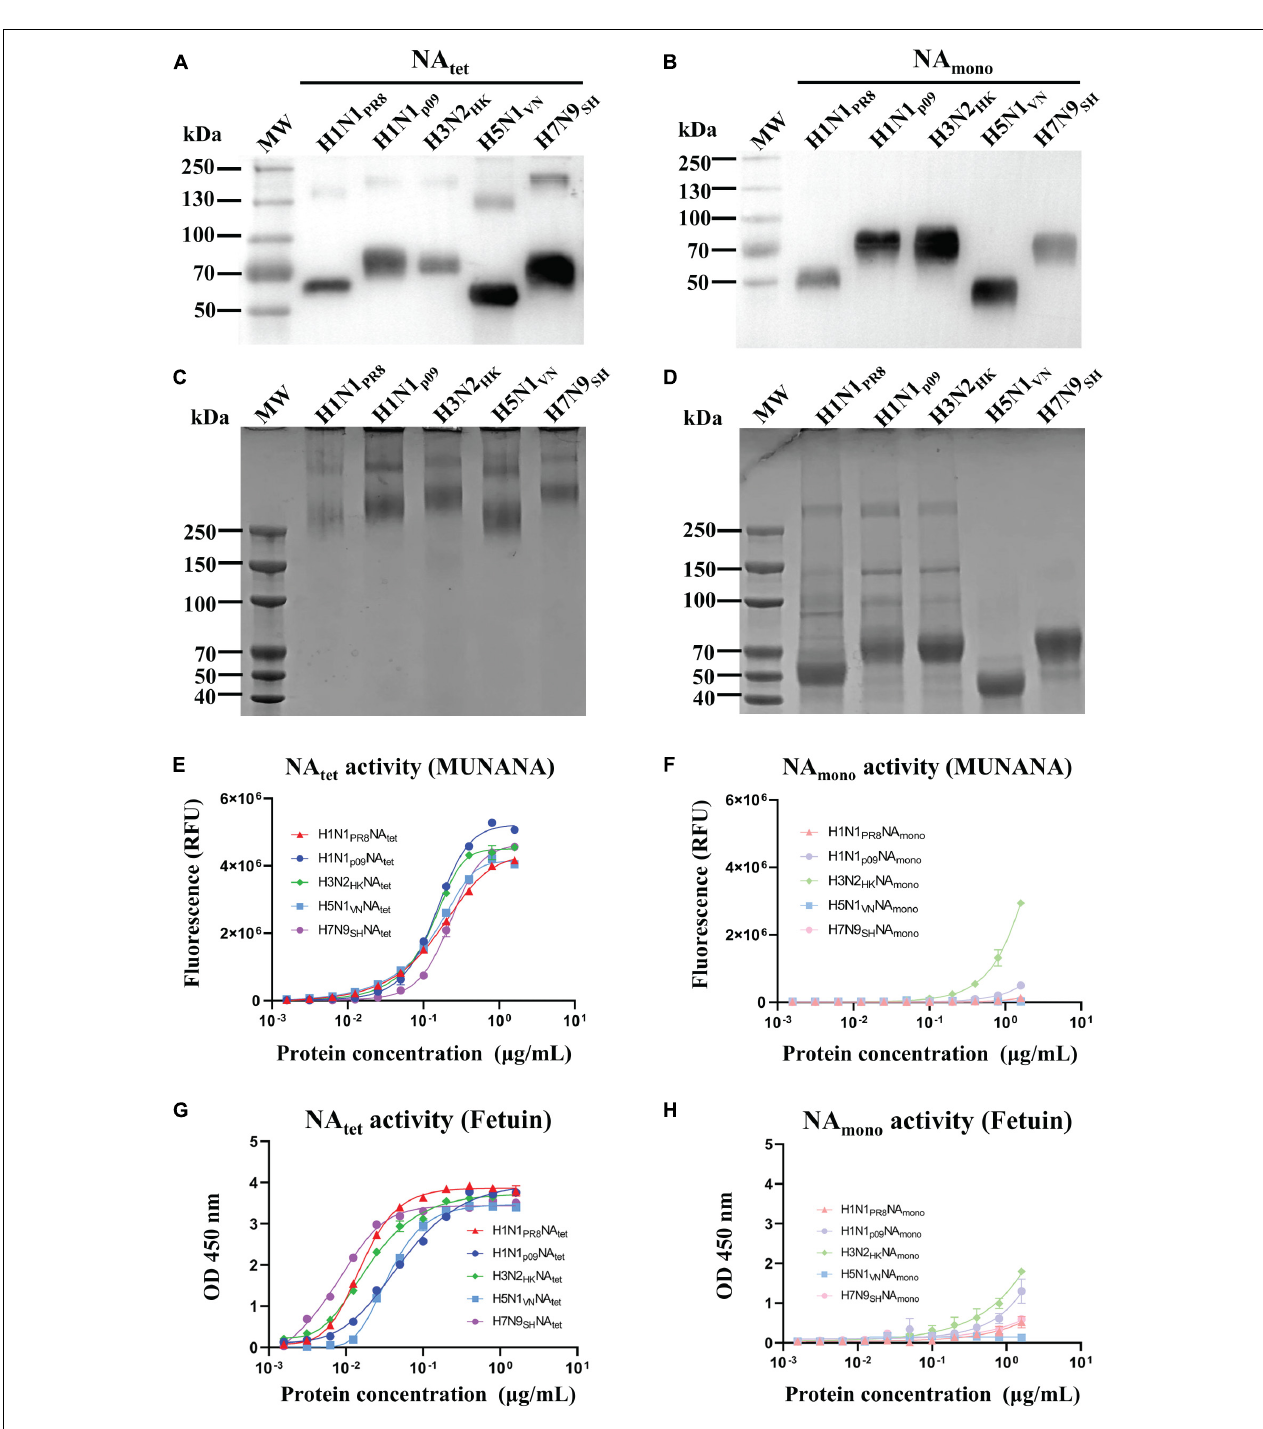
FIGURE 1 | Expression, purification, and characterization of recombinant neuraminidase (NA) proteins. Tetrameric and monomeric NA proteins derived from A/Puerto Rico/8/1934 (H1N1), A/Shanghai/37T/2009 (H1N1), A/Hong Kong/16/68 (H3N2), A/Vietnam/1204 (H5N1), and A/Shanghai/4664T/2013 (H7N9) were expressed by the Expi293F cell expression system and purified by Ni-nitrilotriacetic acid (NTA). (A,B) Purified NA proteins were confirmed by Western blotting. (C,D) Cross-linking SDS-PAGE of tetrameric and monomeric recombinant NA proteins. (E,F) MUNANA-based enzymatic activity assays were used to determine the enzymatic activity of recombinant NA proteins. (G,H) Fetuin-based enzymatic activity assays were used to determine the enzymatic activity of recombinant NA proteins.